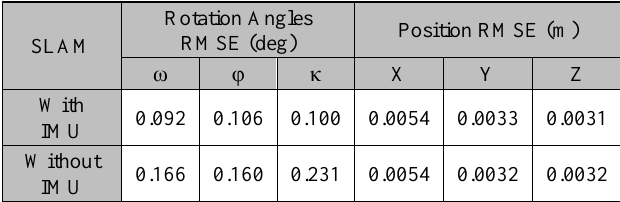
Table 1. RMSE values of all the predicted pose parameters,